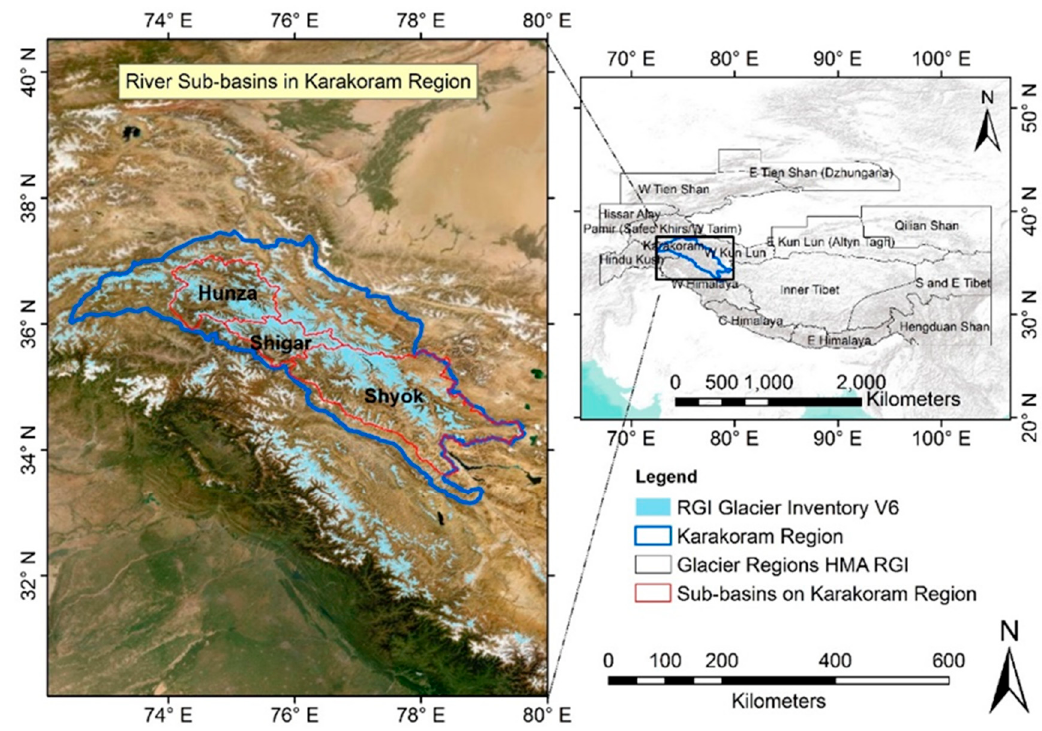
Figure 1. Location map of the Karakoram region.